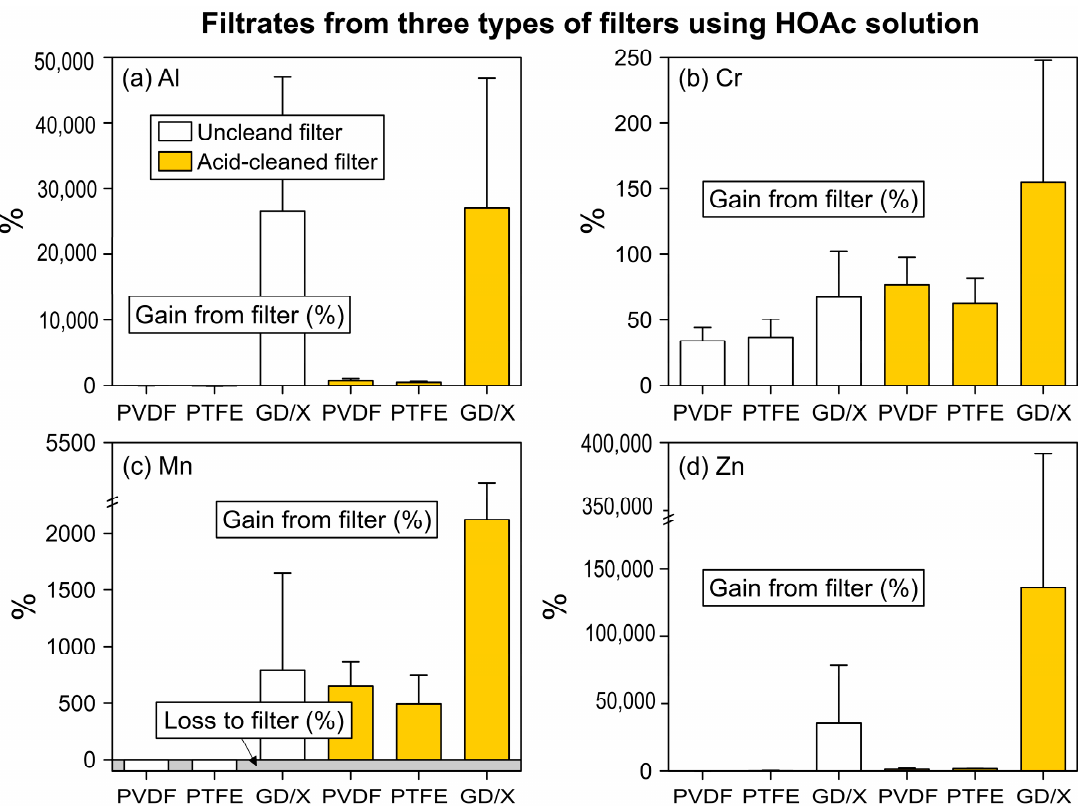
Figure 2. Average percent gains (white zone) from the filters or losses (grey zone) to the filters of trace elements in HOAc solution passing through uncleaned and acid-cleaned membrane filters (PVDF, PTFE, and GD / X), compared to those in the primary solution. The error bars represent